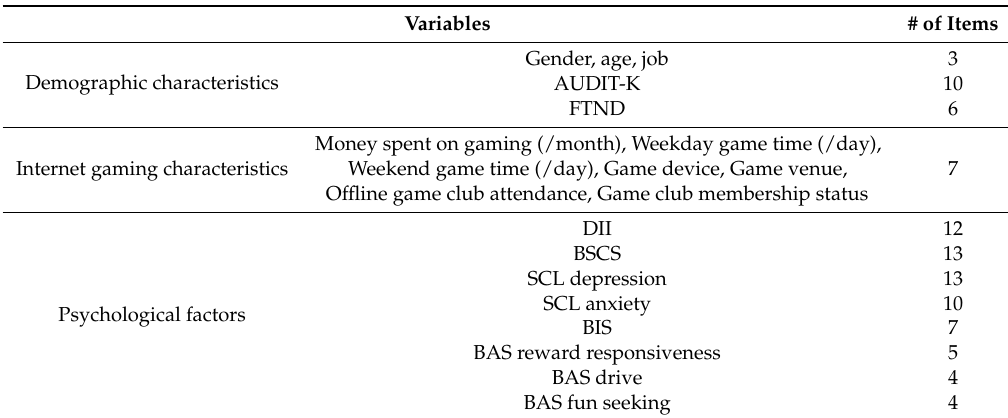
Table 1. Description of Internet gaming characteristics and psychological